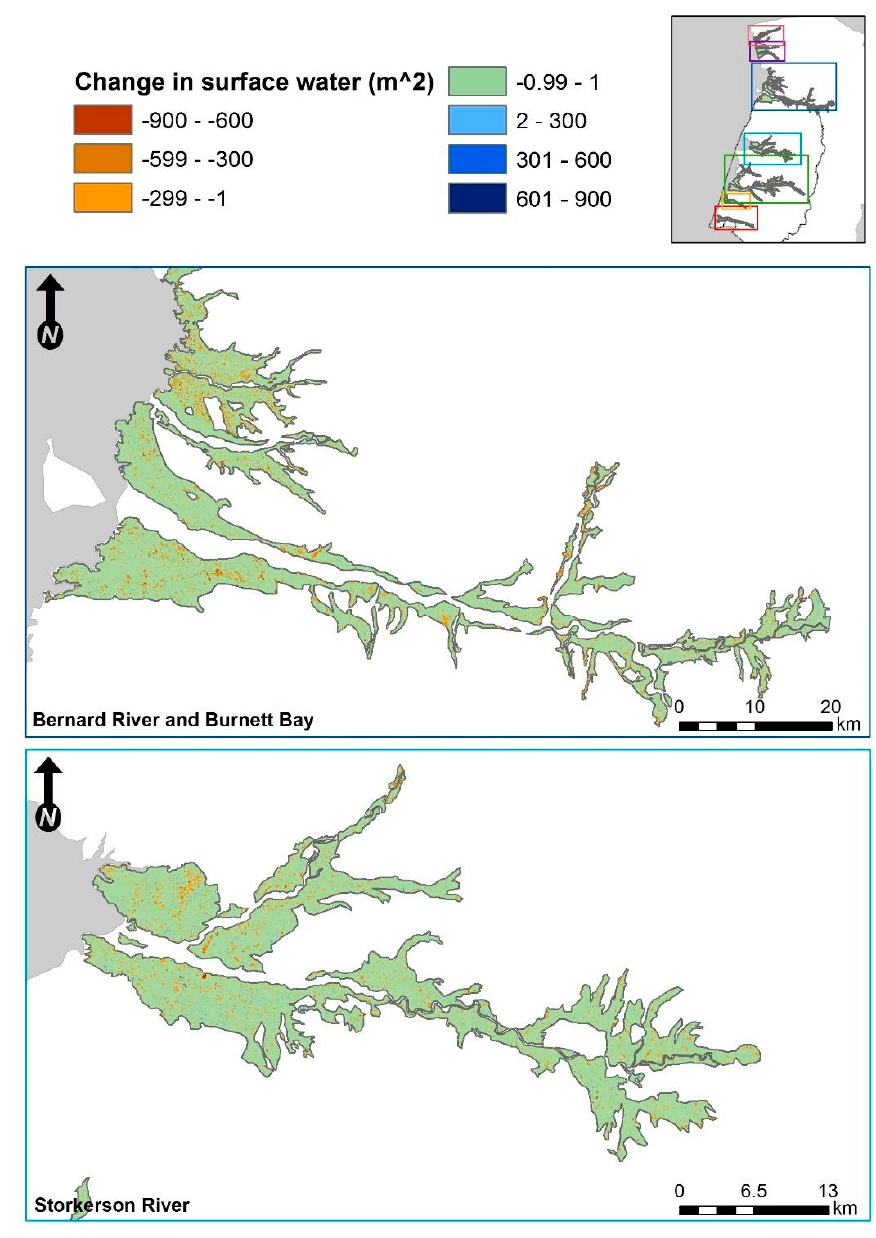
Figure A2. Sub-pixel water fraction trend surfaces of the Burnett Bay area, and the Bernard and Storkerson river valleys of western Banks Island, between 1985–2015.